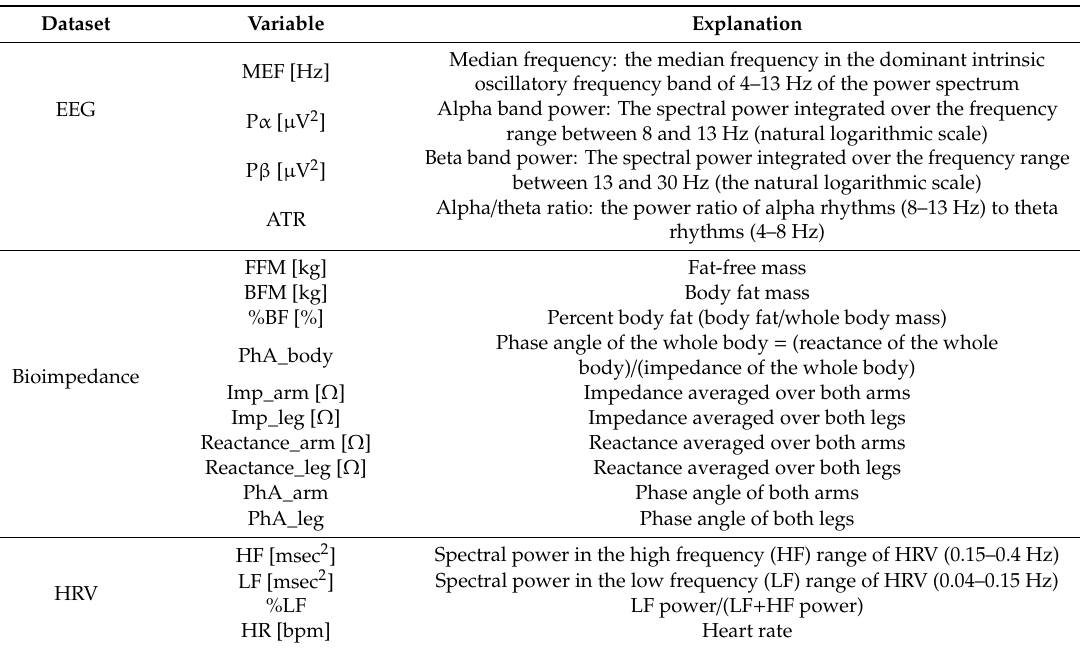
Table 1. Datasets and characteristic variables to be analyzed. EEG, electroencephalogram; PPG,